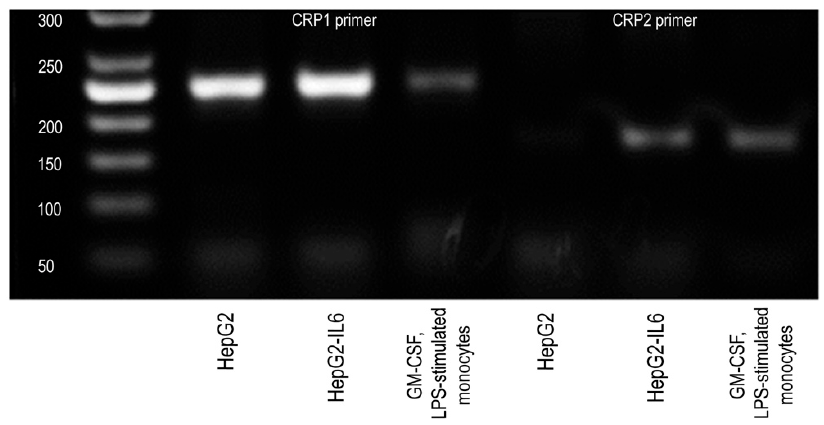
Figure 6. Electropherogram of PCR fragments in 1.5% agarose gel in a tris-acetate-EDTA buffer. Scale to the left: the corresponding number of base pairs. CRP expression was detected in: HepG2—human cell line of hepatocellular carcinoma; HepG2-IL6—interleukin-6-stimulated HepG2 cells; GM-CSF, LPS-stimulated monocytes—granulocyte-macrophage colony-stimulating factor and lipopolysaccharide-stimulated peripheral blood monocytes; b.p.—base pairs.